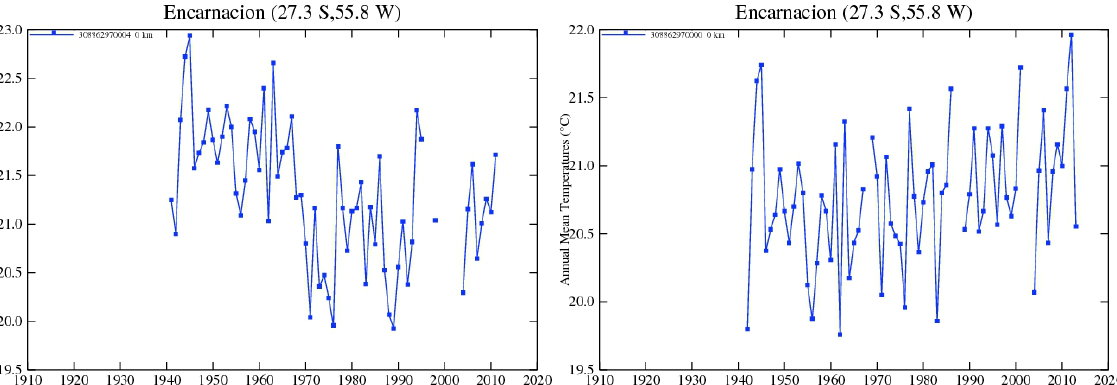
Fig. A.1: (Continued) GISS v2 vs. v3 temperature records for all the stations of Paraguay. In all cases coolings or no warmings have been transformed in significant warmings claiming impossible homogenization with previously massaged data. GISS v2 data on the left, GISS v3 data on the right.